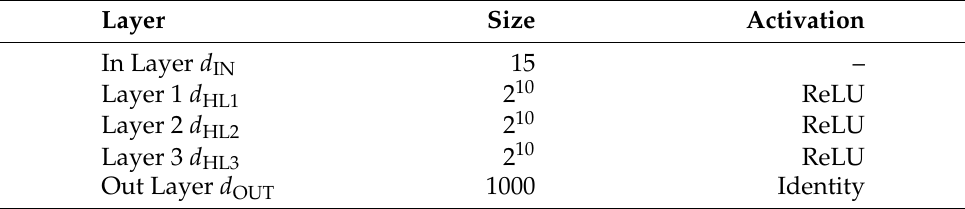
Table 1. Architecture for each trained